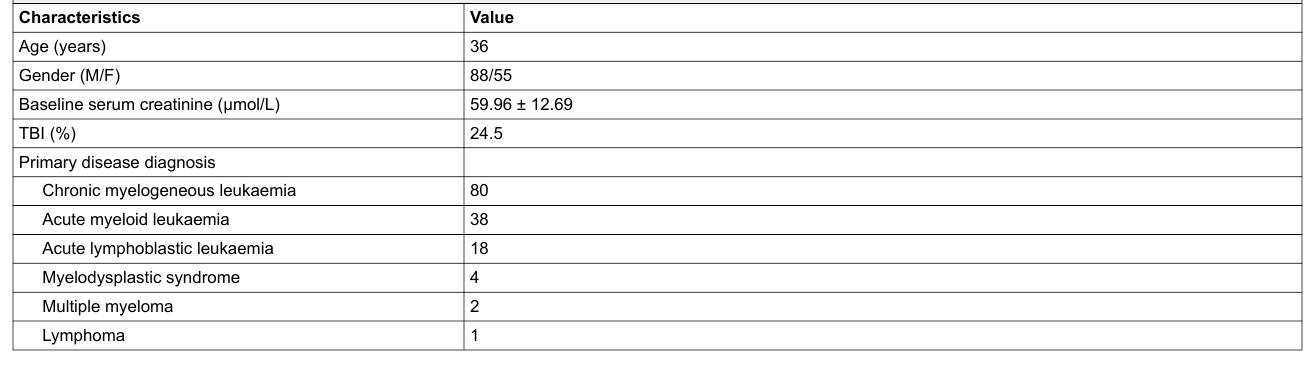
Table 1: Patient demographics and primary diagnosis for the entire cohort. Characteristics